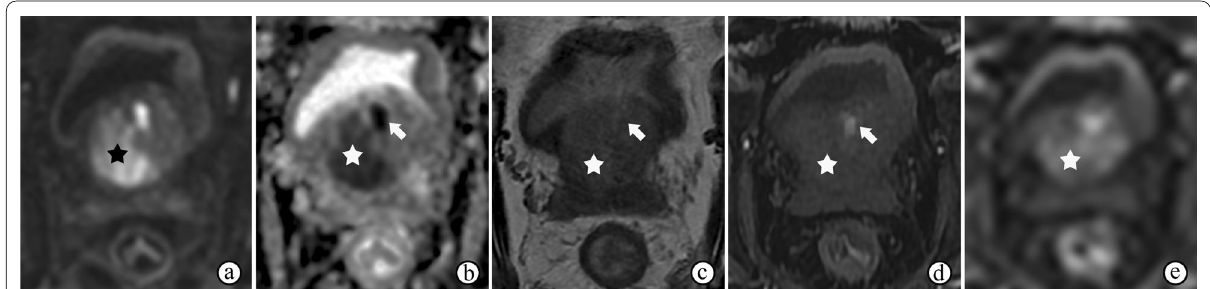
Fig. 7 Intraductal carcinoma of the prostate in an 80-year-old man, with an elevated serum PSA level for 2 years, which was 24.46 ng/mL at the most recent measurement. a, b DWI at a b-value of 1400 s/mm 2 and ADC maps show a lobulated mass with restricted diffusion in the prostate ( ☆ ). c Axial T2-weighted imaging shows isointensity with an ill-defined edge of the mass ( ☆ ). d, e Axial DCE MRI at 60 s ( d ) and 80 s ( e ) after contrast injection shows no prominent enhancement of the mass ( ☆ ). Note the hemorrhagic area in the prostate gland (arrow)